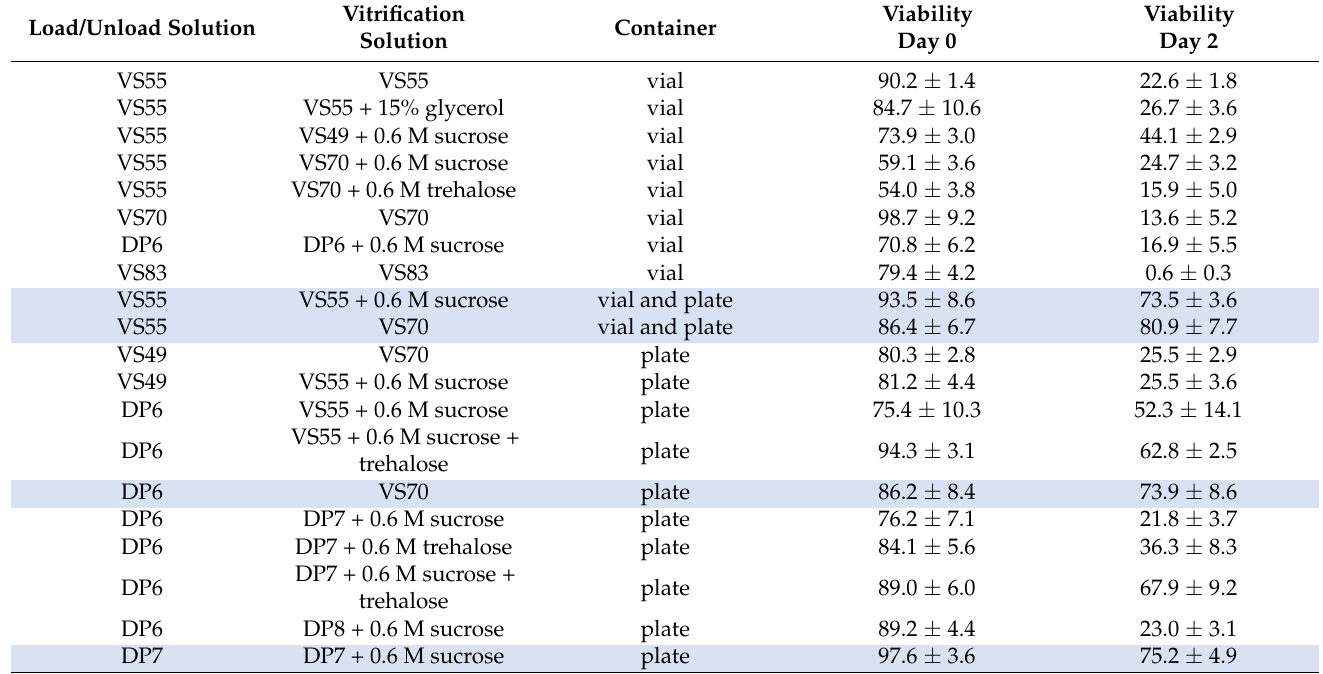
* Solution composition listed in Table